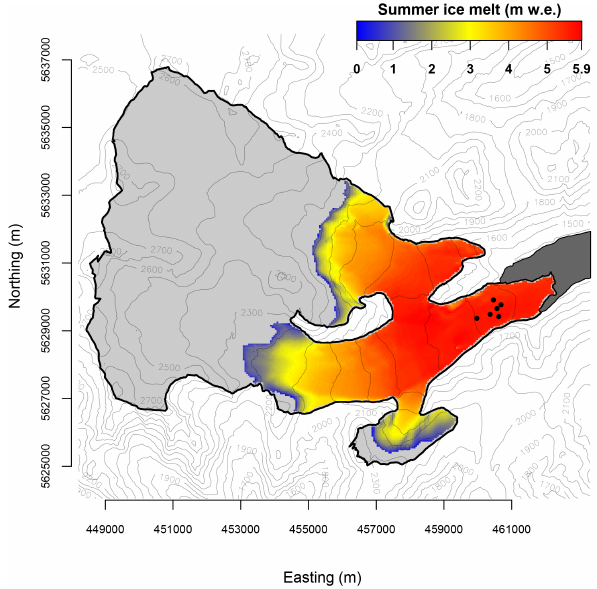
Figure 8. Modelled surface melt and the location of ablation stakes (black dots) for the study period 20 June to 12 September 2013.